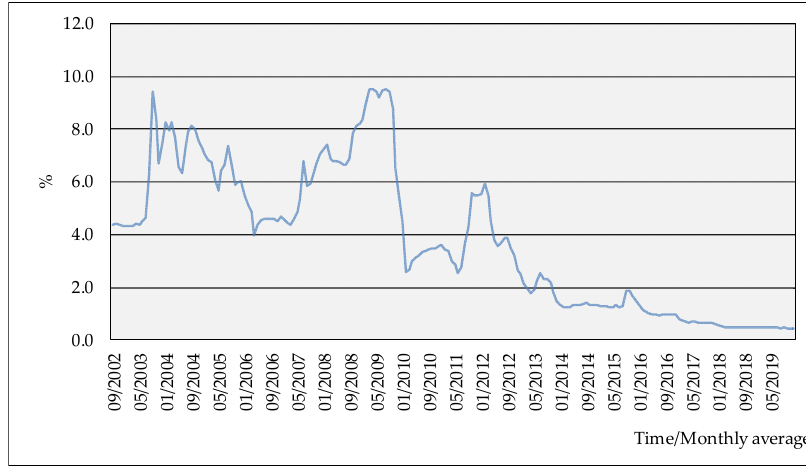
Figure 4. Six-month LIBOR, daily data for the 2 January 2002–2 December 2020 period. Source: Author’s presentation of Bloomberg data.